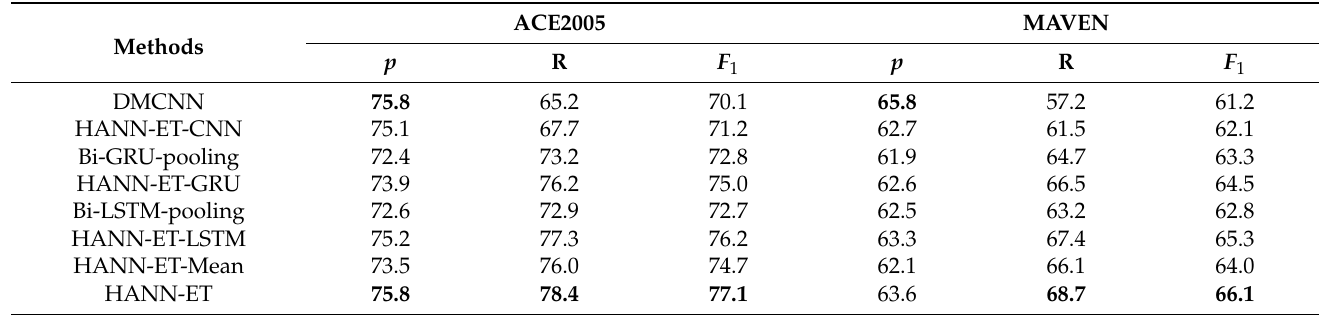
Table 5. Results of ablation experiments on two datasets in the case of cross-validation (%).